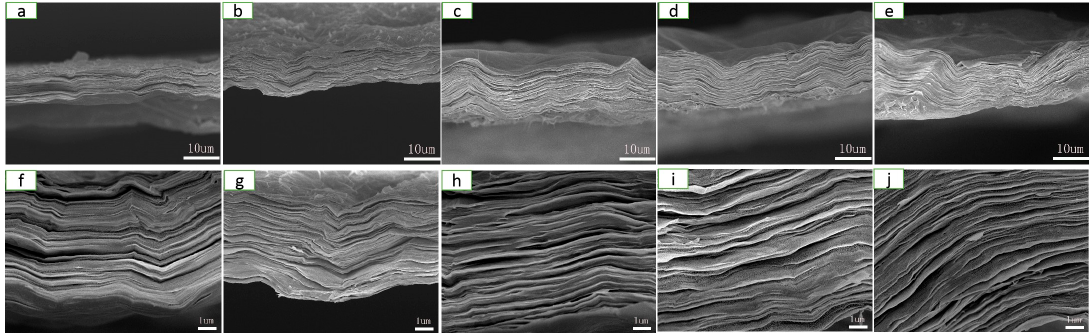
Figure 2. Cross-section field emission scanning electron microscope (FESEM) images of the ( a , f ) RGO, ( b , g ) CNFs / RGO 13 , ( c , h ) CNFs / RGO 12 , ( d , i ) CNFs / RGO 11 , and ( e , j ) CNFs / RGO 21 films.